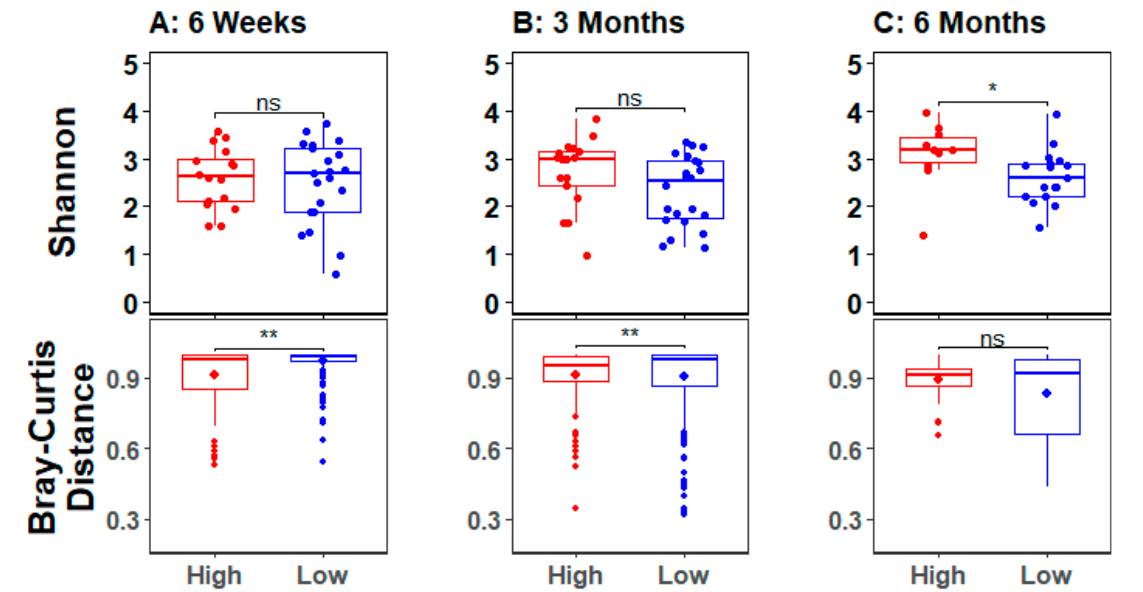
Figure 2. Gut microbial beta and alpha diversity at three ages for infants of high and low stress mothers. Microbial alpha diversity, calculated as Shannon’s richness, is plotted in the top row, and beta diversity, calculated as the Bray-Curtis Distance, is plotted in the bottom row for infants of high and low stress mothers at six weeks ( A ), three months ( B ), and six months ( C ). In the Shannon plots, points indicate individual samples, and, in the Bray-Curtis plots, the central diamond indicates the mean and points outside of the quartiles represent outliers, i.e., there are fewer outliers at six months compared to the other ages. * indicates p < 0.05, ** indicates p < 0.01, and ‘ns’ indicates no signi fi - cance.